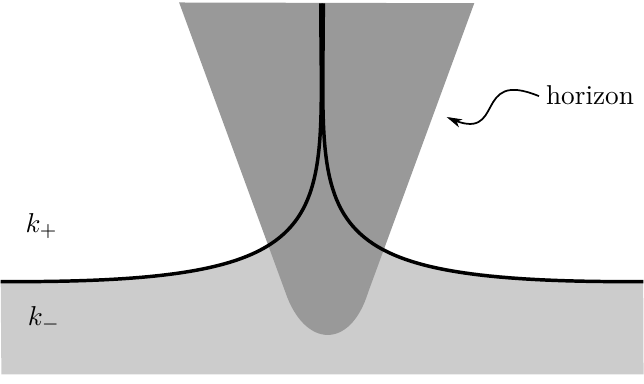
Figure 3. A dark bubble with a black hole with its interior shown in dark gray. The horizon extends below the brane, into the dark bubble and is smoothly capped off at small z